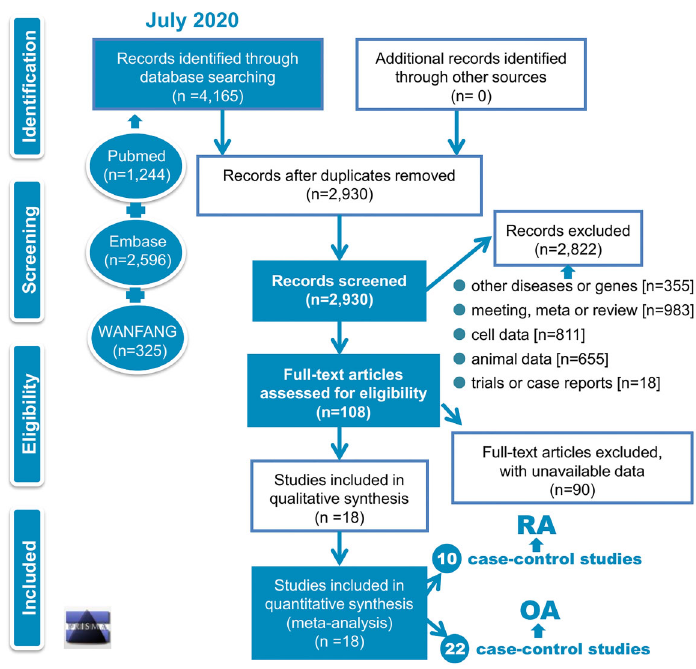
Figure 1. Flowchart of study identi fi cation. RA: rheumatoid arthritis; OA: osteoarthritis.